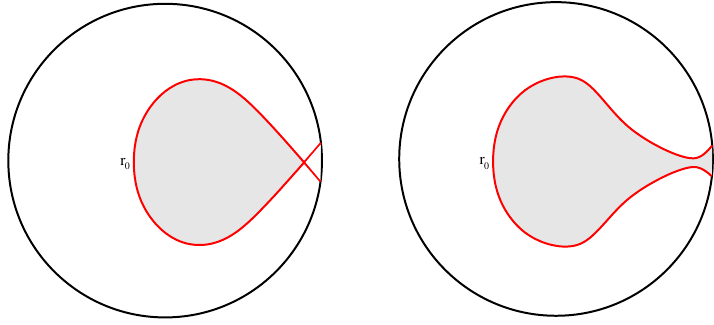
Figure 10 . Left: Euclidean ETW brane trajectories for d > 2 and T (cid:3) ( r H ) < T < T crit . The naive ETW brane trajectory overlaps itself. Right: a possible alternative picture in a more complete holographic model with self-interactions of the ETW